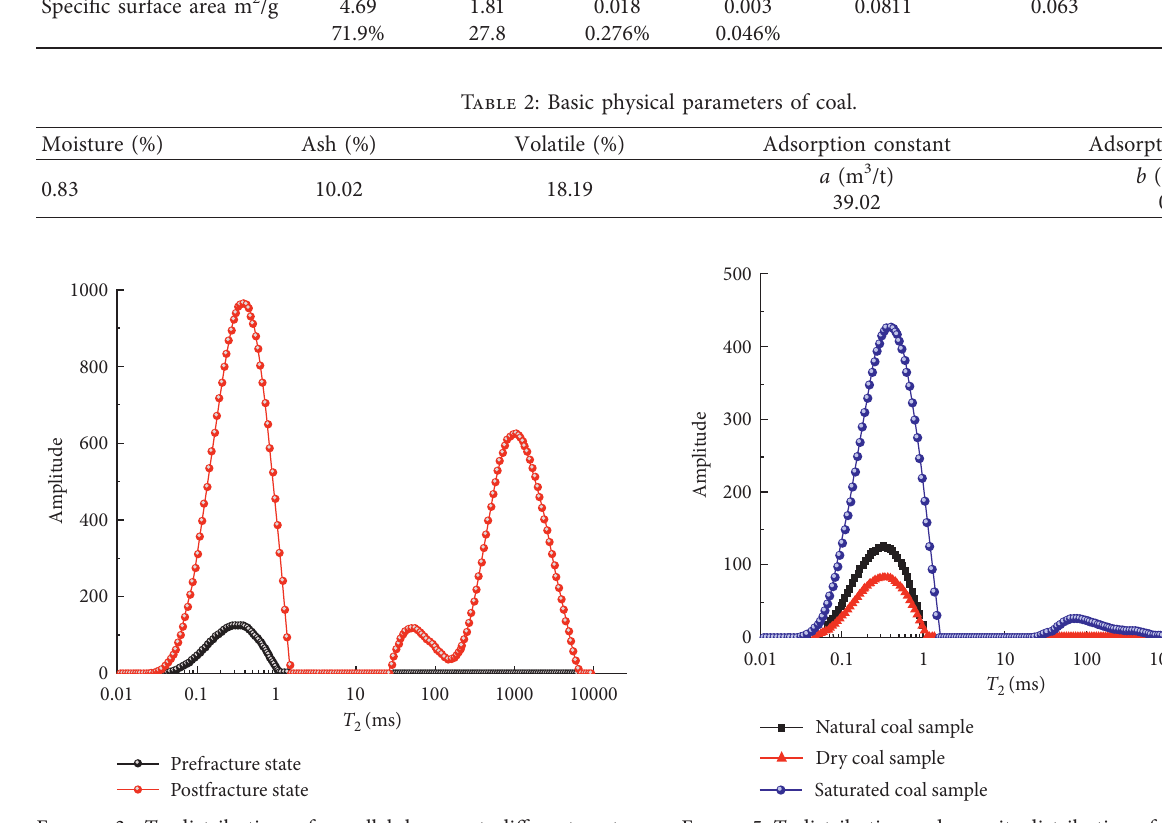
Figure 5: T 2 distribution and porosity distribution of parallel layers at different water conditions.